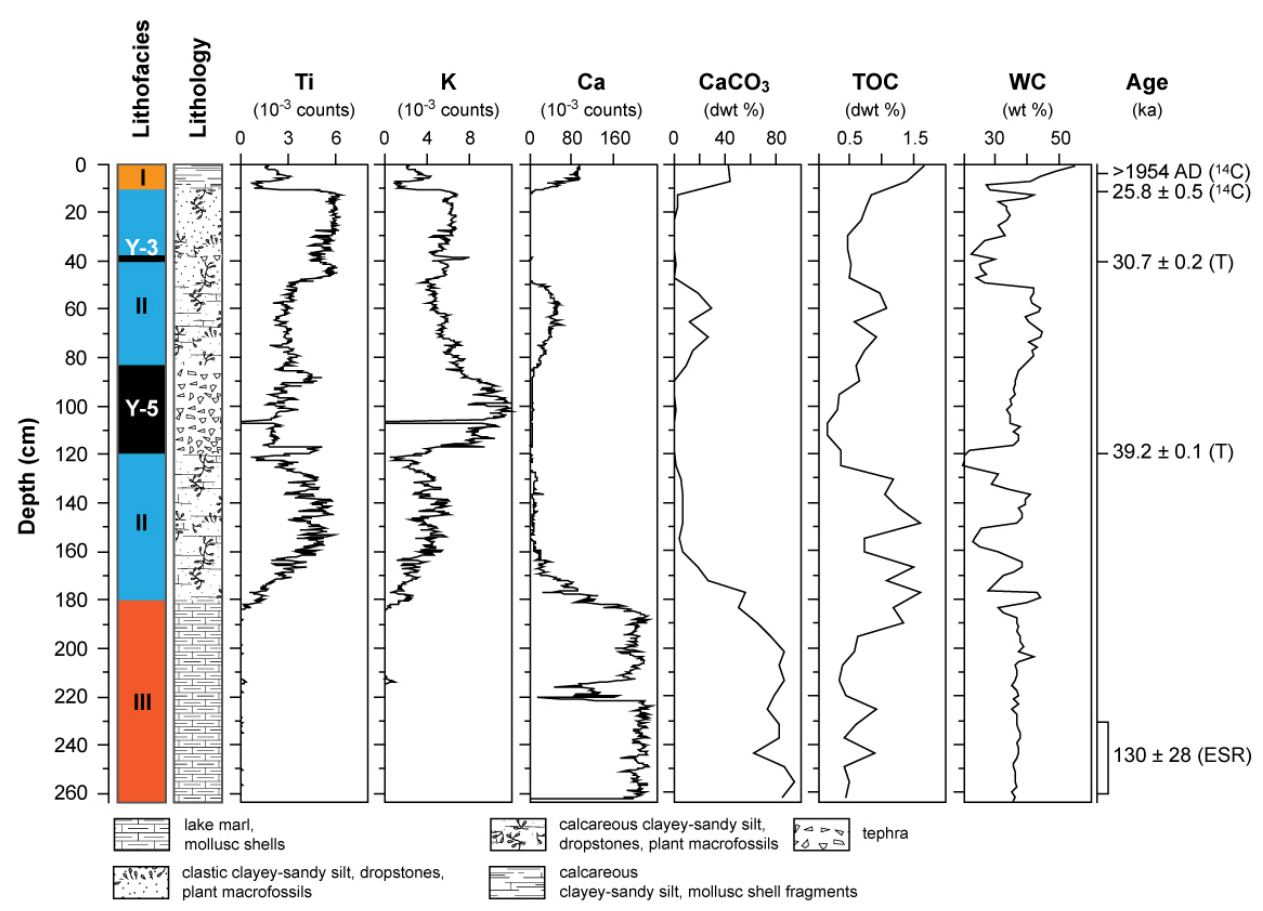
Fig. 5. Lithofacies, lithology, Ti-, K- , Ca- intensities, CaCO 3 , total organic carbon (TOC) dry weight percentages, water content (WC), and age control points of core Co1200. 14 C=calibrated radiocarbon age, T=tephra age, ESR = electron spin resonance age. Location of core is shown on Figs. 3 and 4.